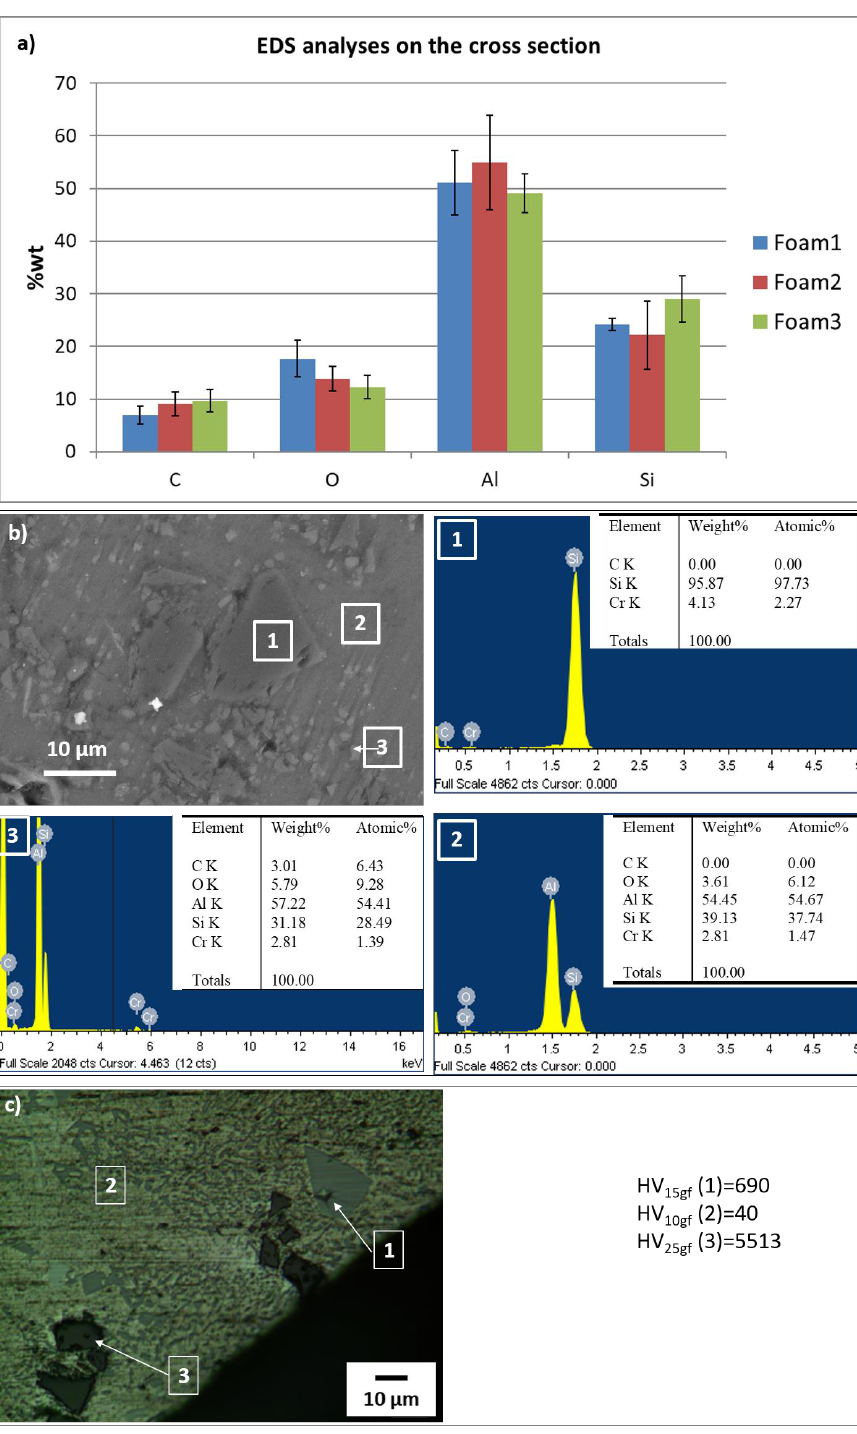
Figure 4. SEM-EDS analyses ( a ) on the cross section of the different foams; ( b ) on localized regions of the cross section; and ( c ) micro-hardness measurements in selected